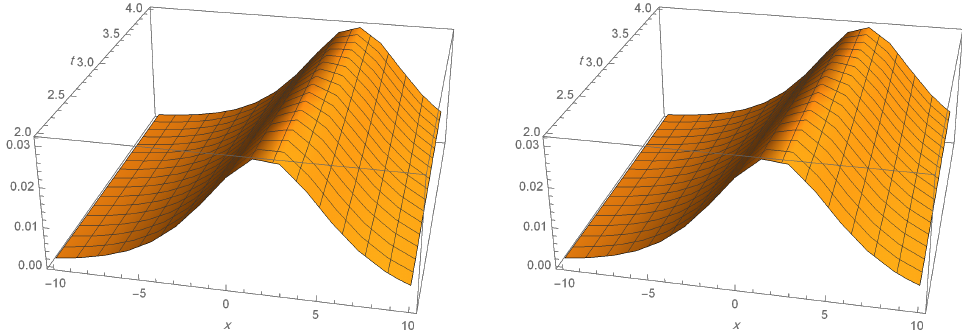
Figure 3. The ADM soliton solution ( left ) with exact ( right ) for MRLW for c = 0.01 and 2 ≤ t ≤ 4.